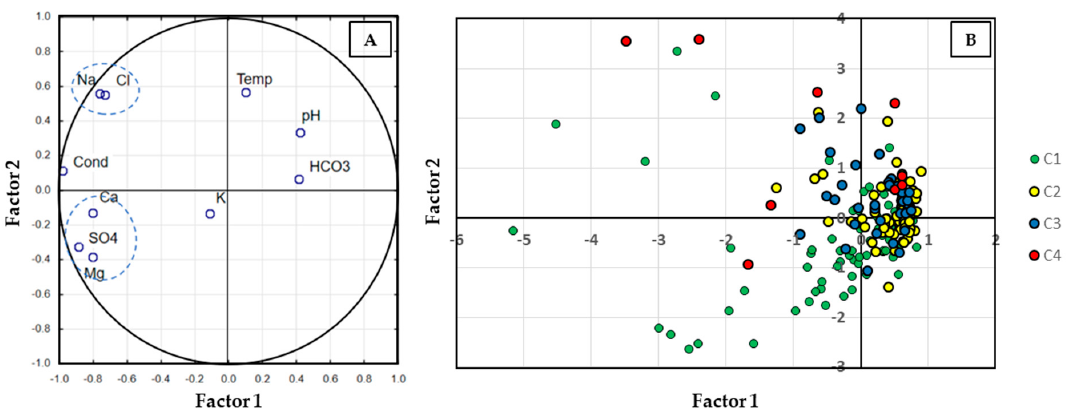
Figure 13. ( A ) Projection of initial variables on factors F1-F2 plane. ( B ) Plot of water samples on the plane associated with factors 1 and 2.